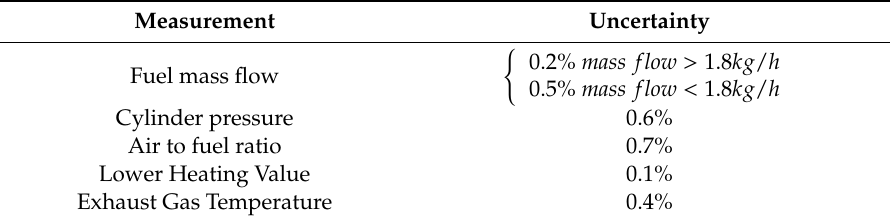
Table 2. Measurements